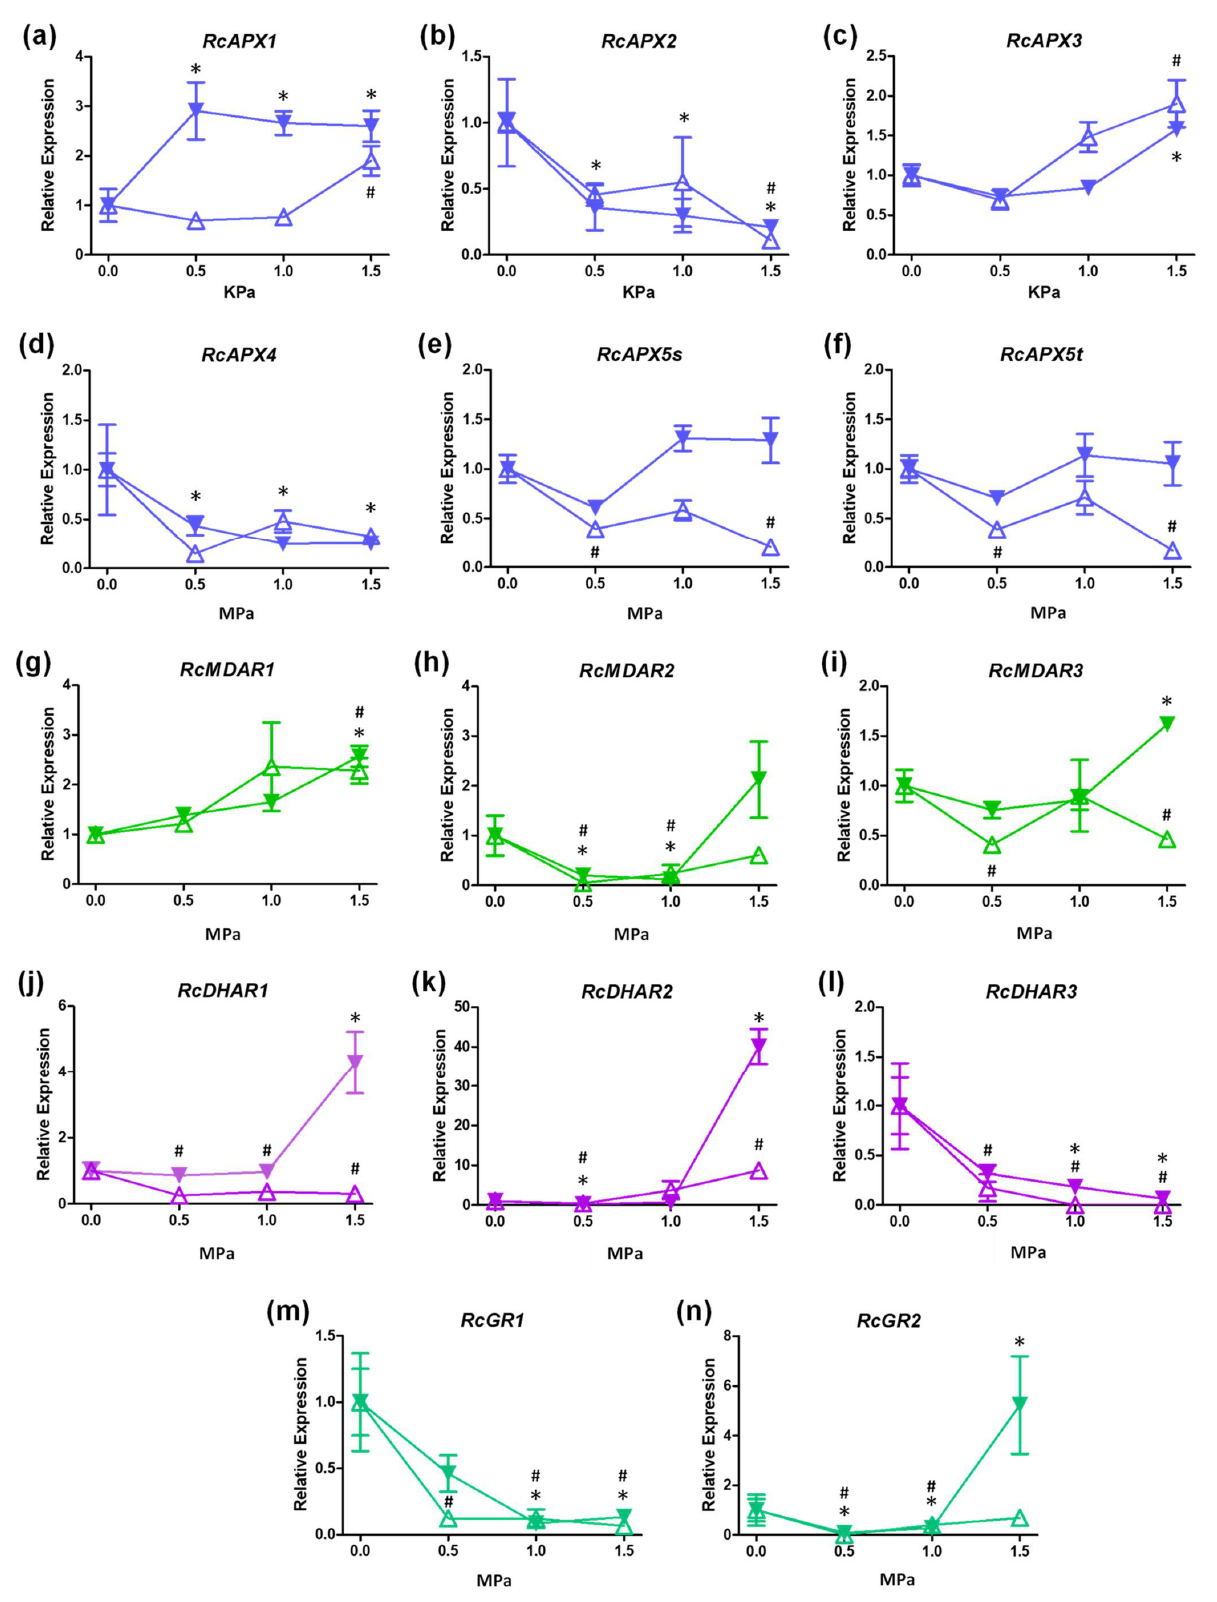
Figure 6. Expression profile APX, MDAR, DHAR, and GR genes in leaves and roots of castor bean submitted to drought stress. Relative expression of RcAPX1 ( a ), RcAPX2 ( b ), RcAPX3 ( c ), RcAPX4 ( d